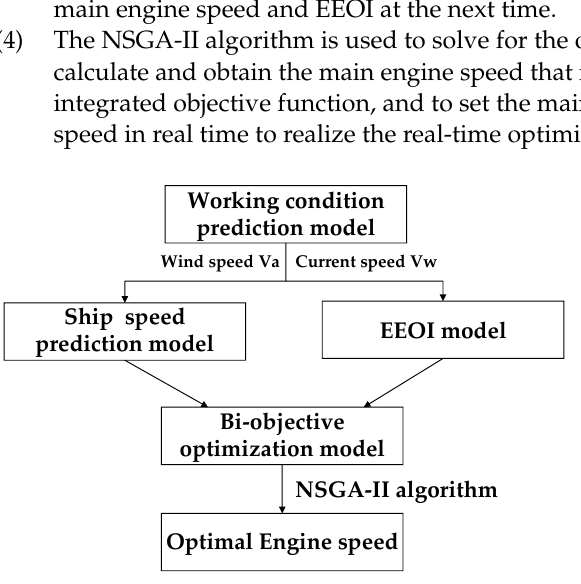
Figure 2. Ship main engine speed-optimization method.